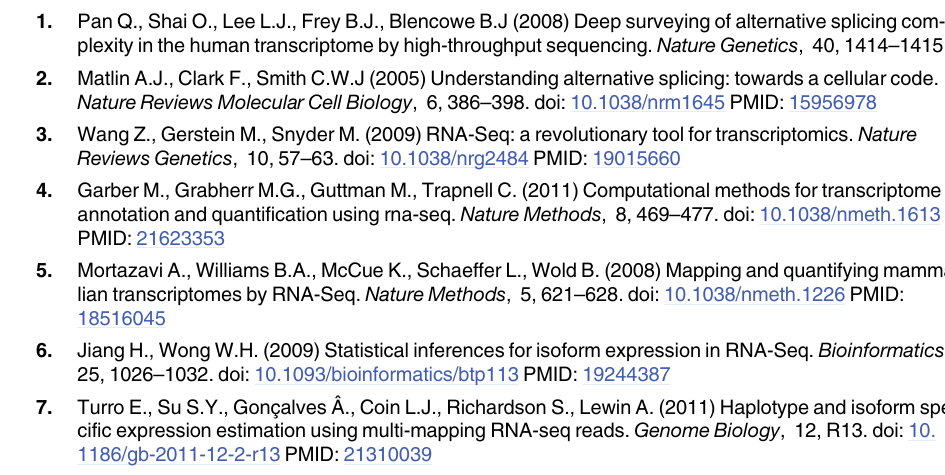
S1 Fig. ROC curves from the four approaches for datasets validated by three methods. The datasets are validated by the three methods except (a) Cufflinks, (b) RSEM, (c) MMSEQ and (d) PGSeq. S2 Fig. Scatter plots of the averaged logged RPKM estimation for lowly expressed genes in HDB dataset. The common DE genes (represented by red triangles) are agreed by three meth- ods except (a) Cufflinks, (b) RSEM, (c) MMSEQ and (d) PGSeq, respectively. Others are repre- sented by green